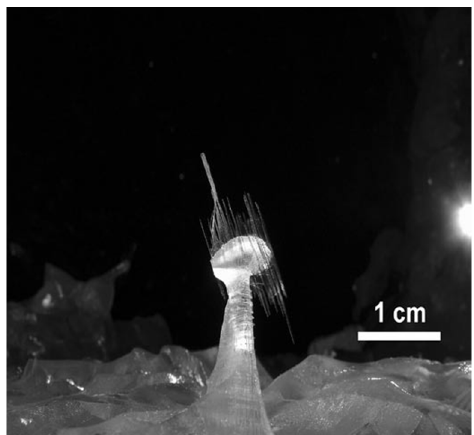
Figure 3. Atypical growth in “Cueva de las velas”. Figure reproduced from Bernabei et al. (2007) [38] and published under a Creative Commons License https://creativecommons.org/licenses/by- nc/4.0/.